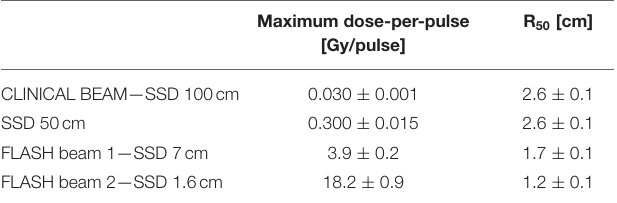
TABLE 2 | Maximum dose-per-pulse values and R 50 obtained for the two irradiation modalities. Maximum dose-per-pulse